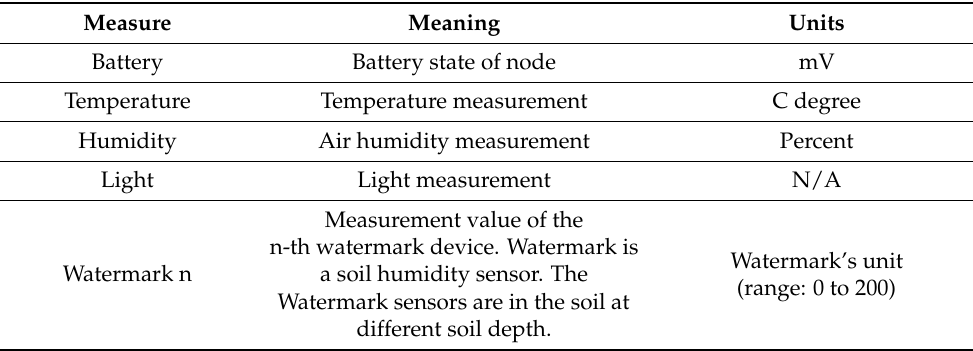
Table 2. Description of the